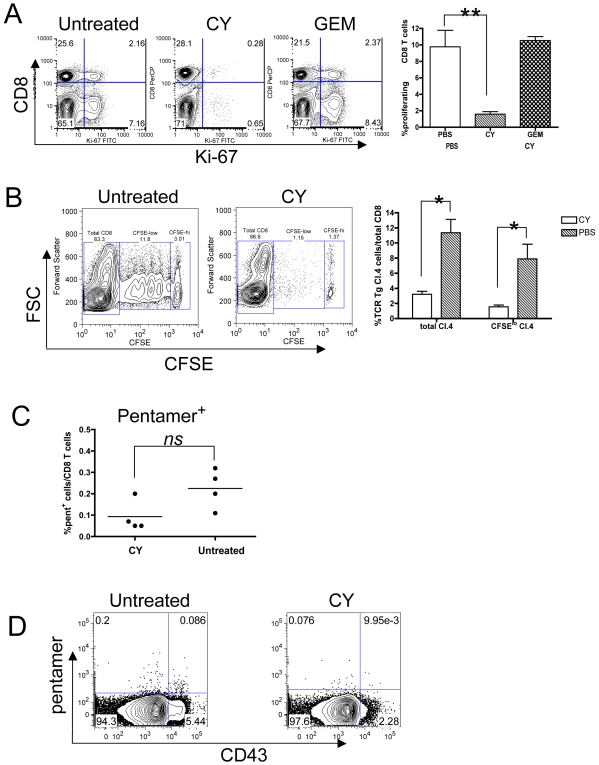
Impaired proliferation of CD8 T cells after CY treatment.(A) Draining lymph node cells from tumor-bearing mice treated with saline, CY or gemcitabine (GEM) at day 10 post inoculation were analyzed for Ki-67 expression three days later. Cells shown were gated such that CD8neg cells are CD4 T cells. Data shown in lower panel are mean±SEM (n = 3) from one experiment. ** P<0.01 when PBS is compared with CY (unpaired t test). (B) Adoptively transferred transgenic CD8 T cells fail to proliferate in CY-treated mice. CFSE-labeled HA-specific clone 4 cells were transferred into tumor bearing mice two days before PBS or CY injection and were harvested 7 days later and stained for CD8 expression. Cells shown are gated as CD8+. Data shown in lower panel are mean±SEM (n = 3) from one experiment. * P<0.05 when PBS is compared with CY (unpaired t test). (C) HA-specific MHC class I pentamer staining in untreated and CY-treated tumor-bearing mice. Data shown are frequencies of pentamer+ CD8 T cells per total CD8 T cells in tumor-draining lymph nodes at day 10 post CY injection. ns = not significant (P = 0.06, unpaired t test). (D) CD43 (clone 1B11) expression on pentamer+ CD8 T cells in tumor-draining lymph nodes. Cells shown are gated on CD8+ cells. Representative plots are shown.